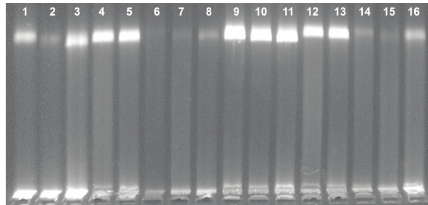
Figure 2: DNA cleavage by the complexes 1, 2, 3, and 4 obtained using agarose gel electrophoresis showing the chemical activity of the DNA incubated at 37 ∘ C for 3 h with different concentrations of complexes1,2,3,and4inthepresenceofH 2 O 2 asanoxidizingagent: lane 4, control (DNA); lane 5, DNA + H 2 O 2 (60 𝜇 M); lanes 1, 2, and 3, DNA + H 2 O 2 (60 𝜇 M) + complex 1 (5, 25, and 50 𝜇 M); lanes 6, 7, 8, DNA + H 2 O 2 (60 𝜇 M) + complex 2 (5, 25, and 50 𝜇 M); lanes 9, 10, and 11, DNA + H 2 O 2 (60 𝜇 M) + complex 3 (5, 25, and 50 𝜇 M); lane 12, control (DNA); lane 13, DNA + H 2 O 2 (60 𝜇 M); lanes 14, 15, and 16, DNA + H 2 O 2 (60 𝜇 M) + complex 4 (5, 25, and 50 𝜇 M).